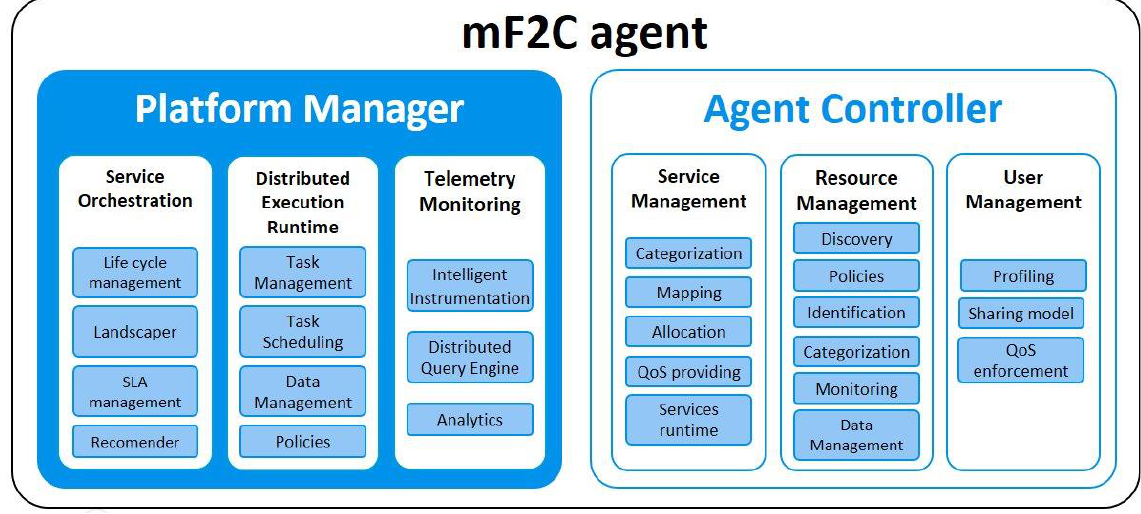
Figure 3. mF2C agent architecture